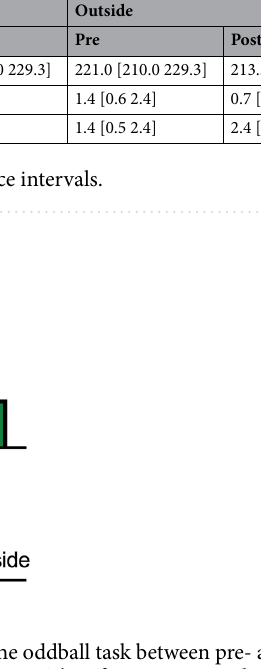
Figure 1. The difference in reaction time and accuracy on the oddball task between pre- and post- indoor and outdoor walk. Value on plot = post walk score − pre-walk score . Therefore, negative values indicate improved performance. Error bars reflect 95% within-subject confidence